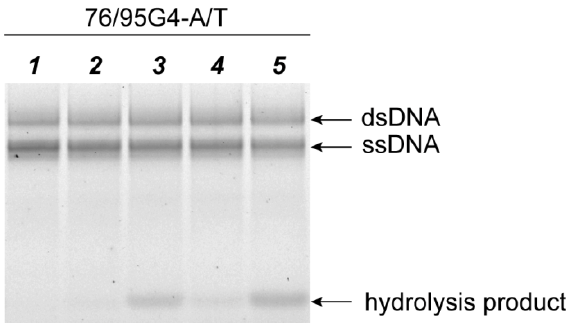
Figure 9. Hydrolysis of G4-containing duplex substrate 76/95G4-A/T under the influence of E. coli MMR proteins. Lane 1: untreated DNA, 2: DNA incubated with 250 nM MutH, 3: DNA incubated with 250 nM MutH and 250 nM MutL (per monomer), 4: DNA incubated with 250 nM MutH and 250 nM MutS (per monomer), 5: DNA incubated with 250 nM MutH, 250 nM MutL, and 250 nM MutS (per monomer). The reaction mixtures were incubated in the presence of 1 mM ATP for 1 h and then electrophoresed in a 10% polyacrylamide gel containing 7 M urea.